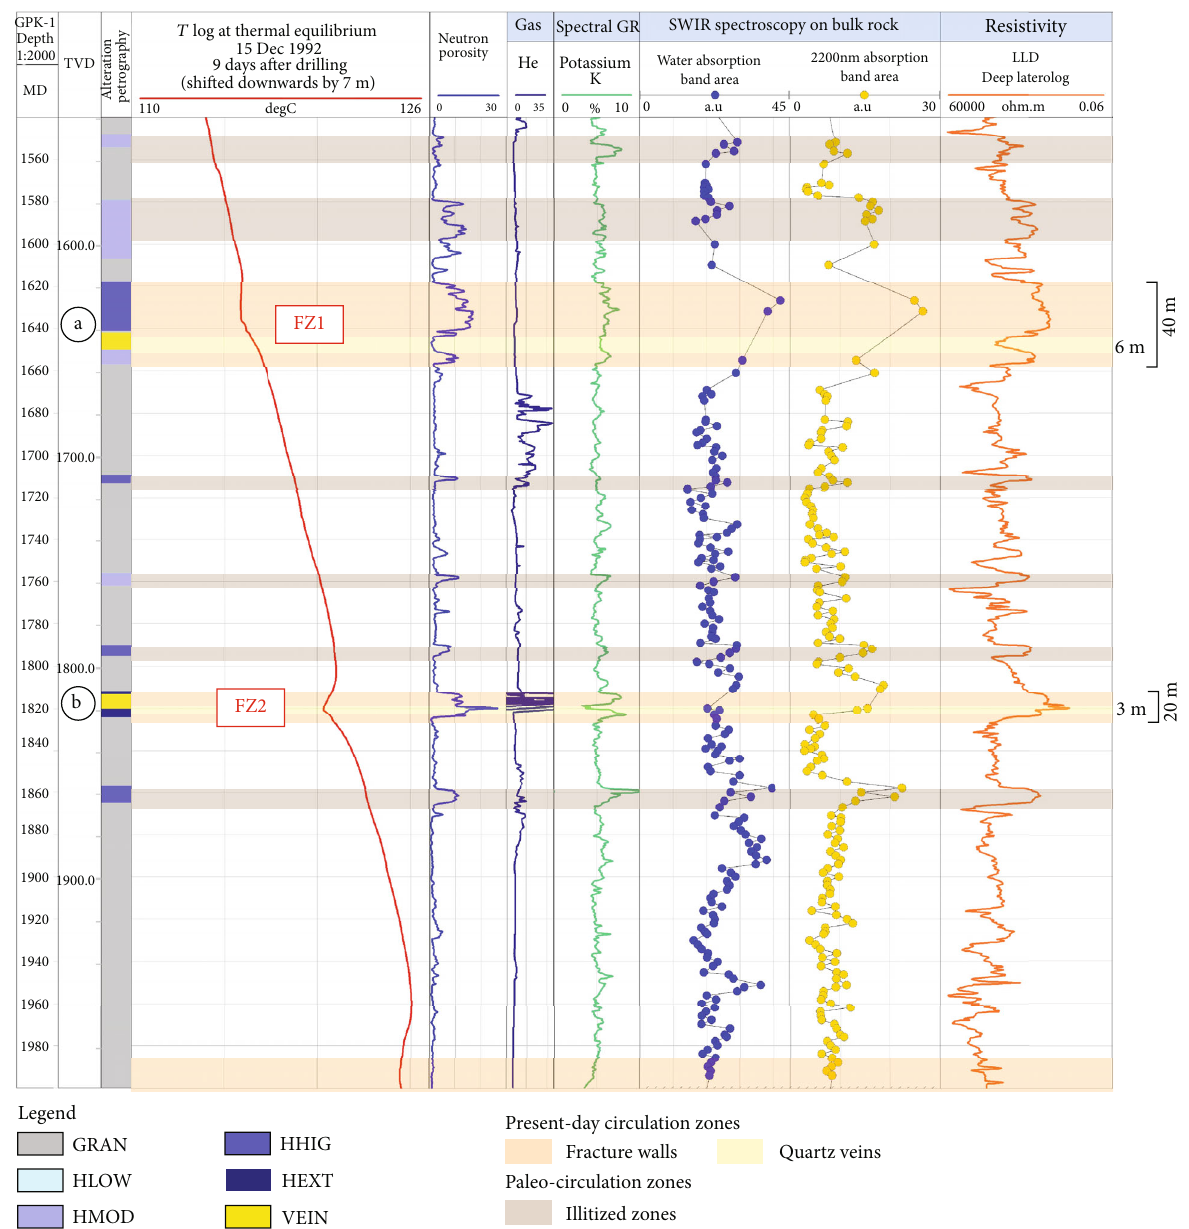
Figure 8: Magni fi ed view of two (a and b) main permeable FZs of the GPK-1 well at Soultz-sous-Forêts, presenting the petrographical log, T log, porosity and density logs, spectral GR-K, SWIR results with water and 2200 nm absorption band areas, and resistivity log. Petrographical facies abbreviations are de fi ned in the legend in Figure